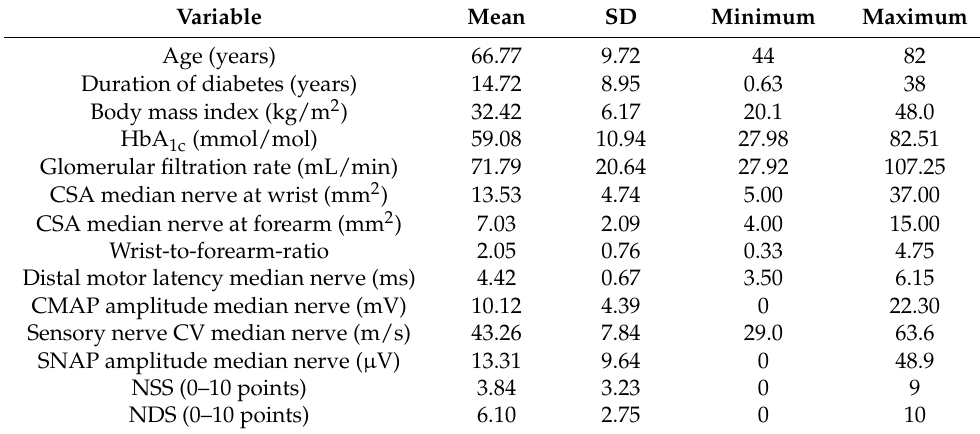
Table 2. Baseline characteristics of the patients (n = 69), metric